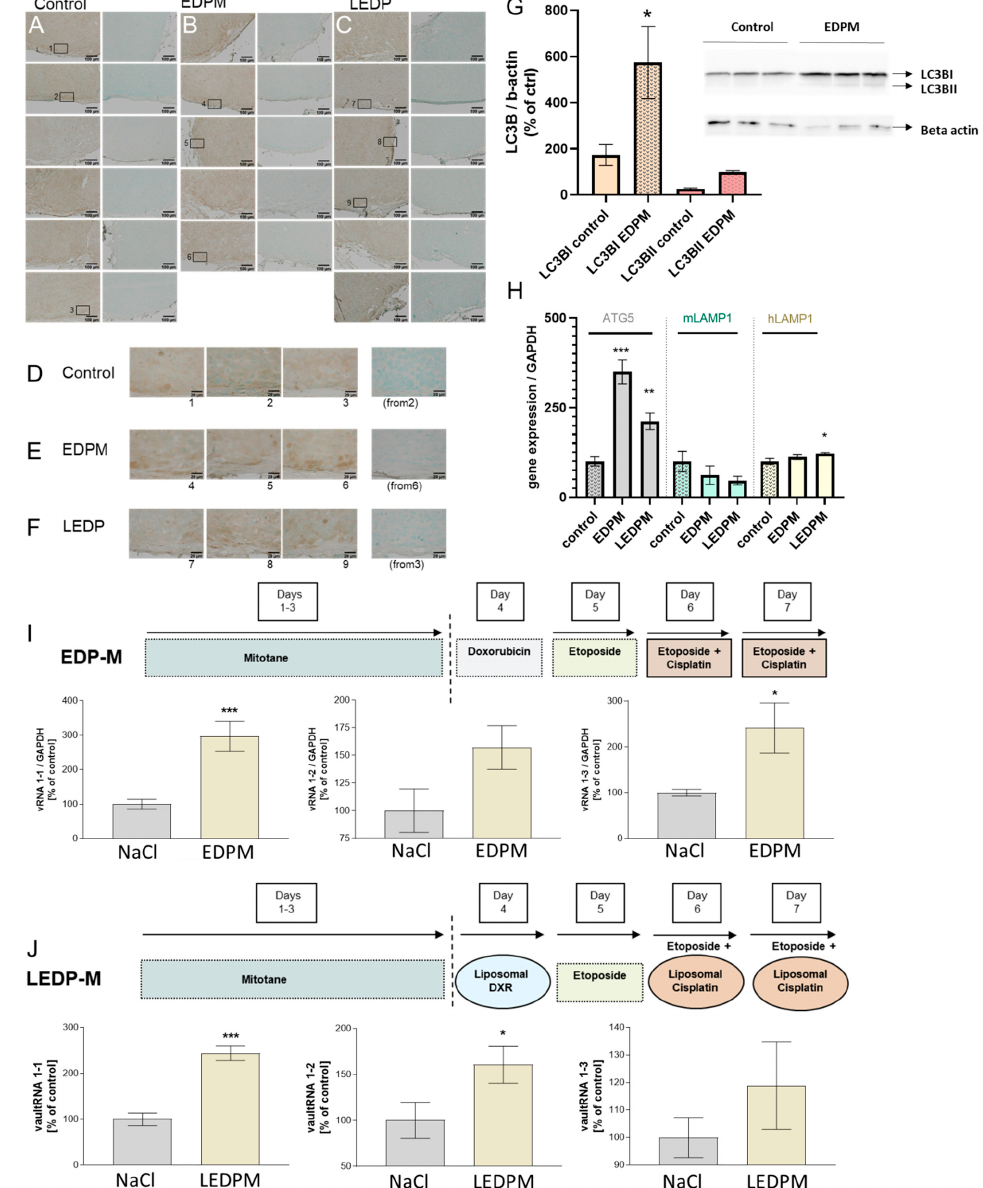
Figure 6. LC3B immunohistochemistry of NaCl- ( A , D ), EDPM- ( B , E ) and LEDPM- ( C , F ) treated NCI-H295R tumors. LC3BI and II quantification of EDPM-treated NCI-H295R tumor cells by western blot in vitro ( G ). ATG5, murine LAMP-1, and human LAMP-1 gene expression analysis in NaCl- , EDPM-, and LEDPM-treated NCI-H295 tumors in vivo ( H ). The statistical significance is based upon one-way ANOVA, including Dunnett-s post-test vs. controls and is denoted as stars (* p < 0.05; ** p < 0.01; *** p < 0.001). Vault RNA1-1, 1-2, and 1-3 real-time PCR analysis of EDPM- ( I ) and LEDPM- ( J ) treated NCI-H295R tumors (two-tailed unpaired t -test).